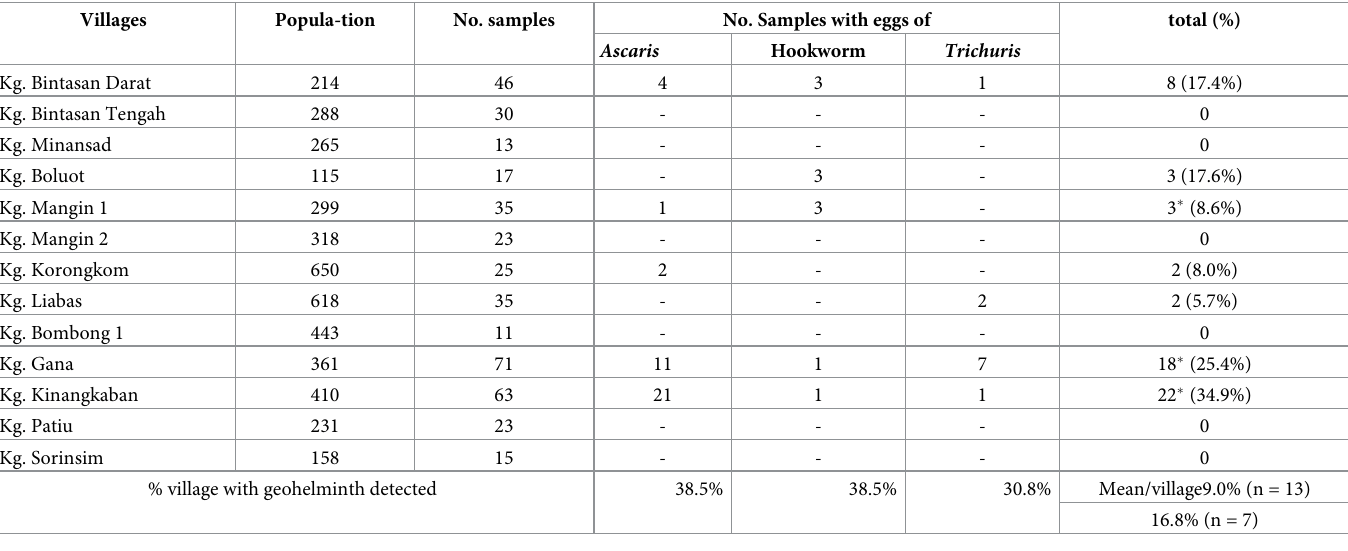
Using univariate analysis, the following factors: age (odds ratio, OR = 0.586) gender (OR = 0.745), the number of people in the household (OR = 1.812), type of house (OR = 1.316), burning of household waste (OR = 1.115), not trimming nails (OR = 1.281), Table 4. Prevalence of geohelminthiasis in each village in Kota Marudu.